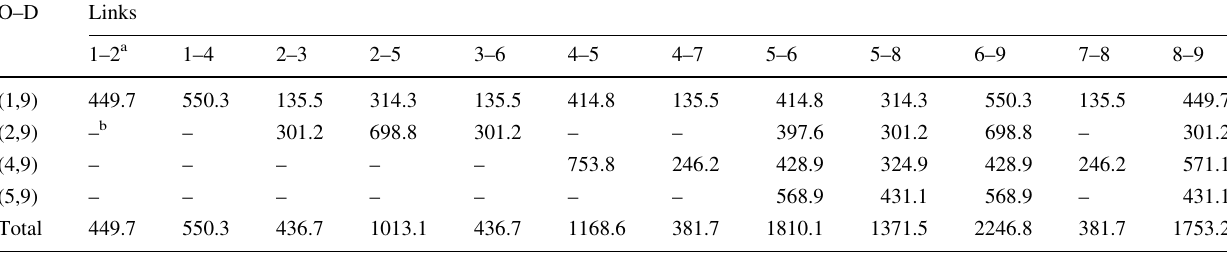
Table 4 Link flow assigned by O–D pairs and total link flow by the weibit model O–D